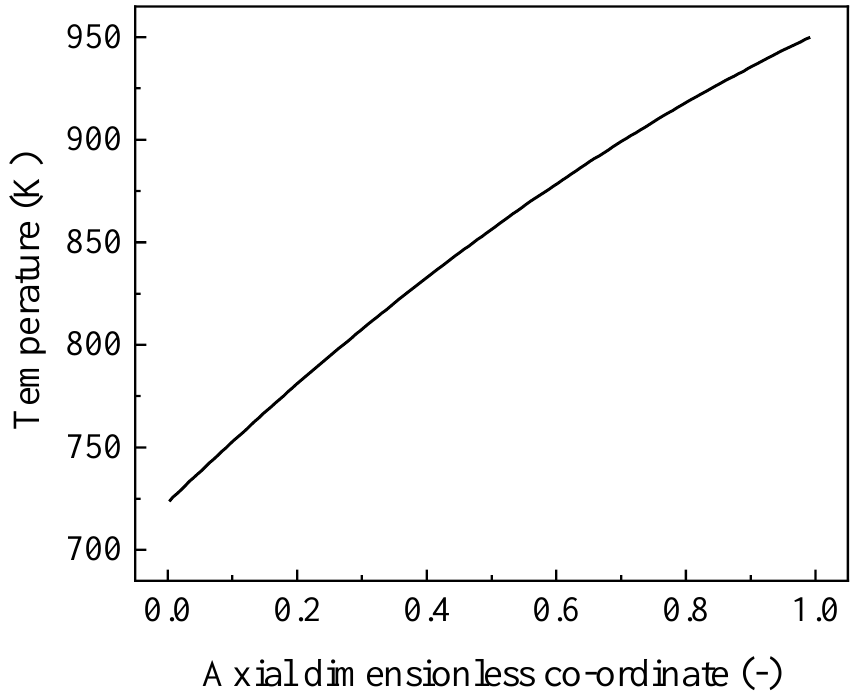
Figure 2. Pre-defined temperature distribution along the combustion catalyst surface of the reformer channel.